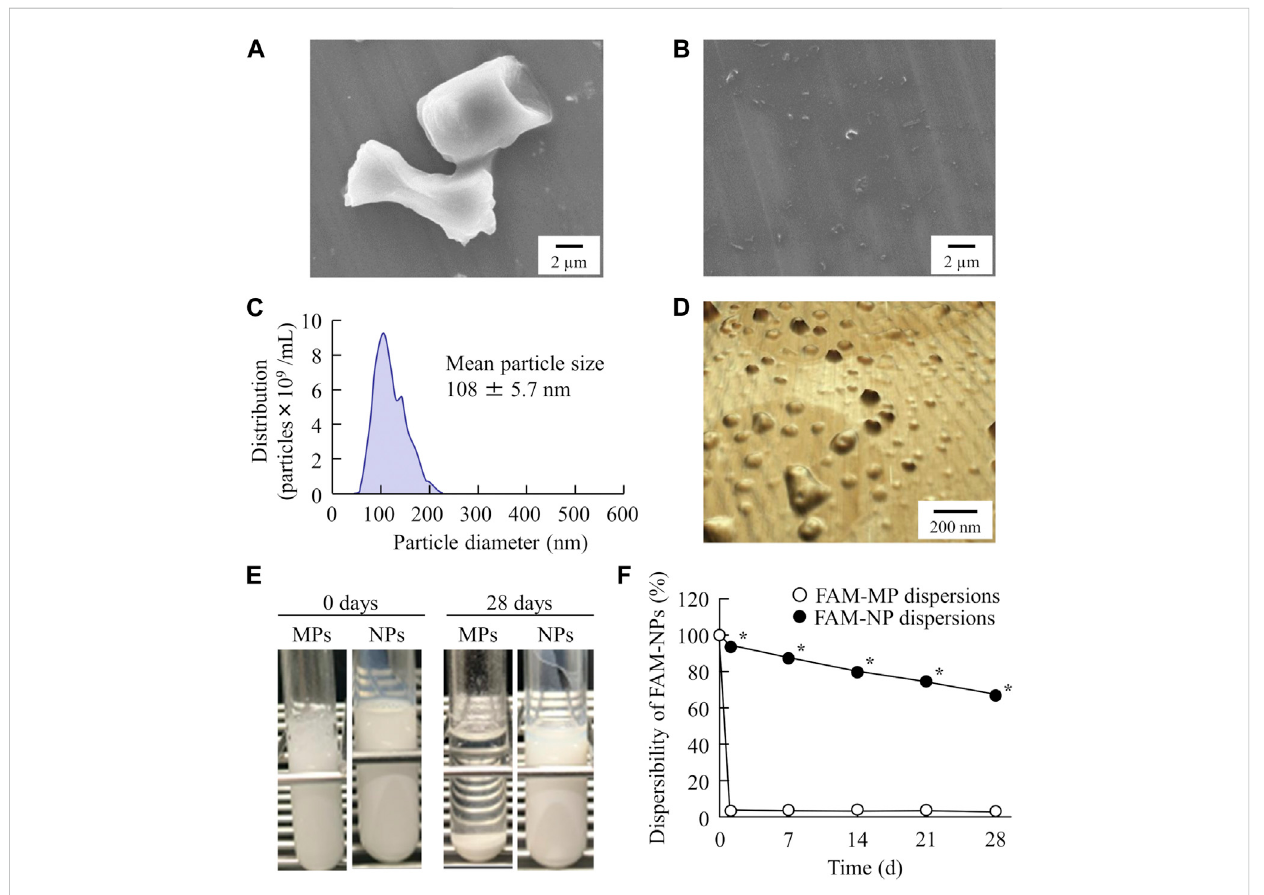
FIGURE 1 Evaluation of FAM particles in the FAM-MP and FAM-NP dispersions. SEM image of FAM in FAM-MP (A) and FAM-NP (B) dispersions. Particle size frequencies (C) and atomic force micrograph (D) of FAM in FAM-NP dispersions. Photograph of FAM-MP and FAM-NP dispersions immediately (0 days) and 28 days after preparation (E) , and dispersibility of FAM in FAM-MP and FAM-NP dispersions for 28 days (F) . n = 10. * p < 0.05 vs. FAM-MP dispersions. The FAM nanoparticles were produced by bead-milling treatment, and the particle size was approximately 50 – 220 nm. The sedimentation in the FAM-NP dispersions was gradual in comparison with that in the FAM-MP